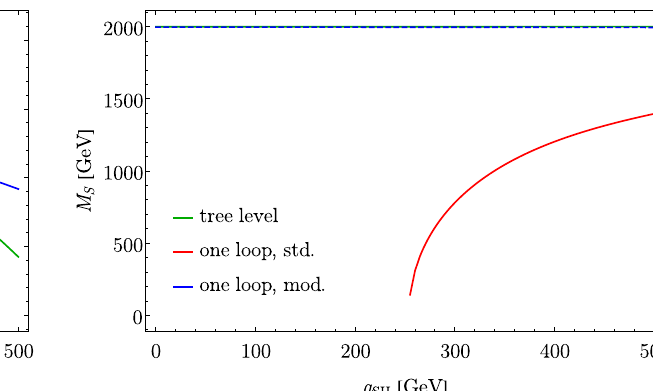
Fig. 2 M h (left) and M S (right) as a function of a SH . m tree 2000GeV, a S = 100 GeV, λ = 0 . 52, λ SH = 0, λ S = 1 / 24. The tree-level values are shown with the green curves, while the red and